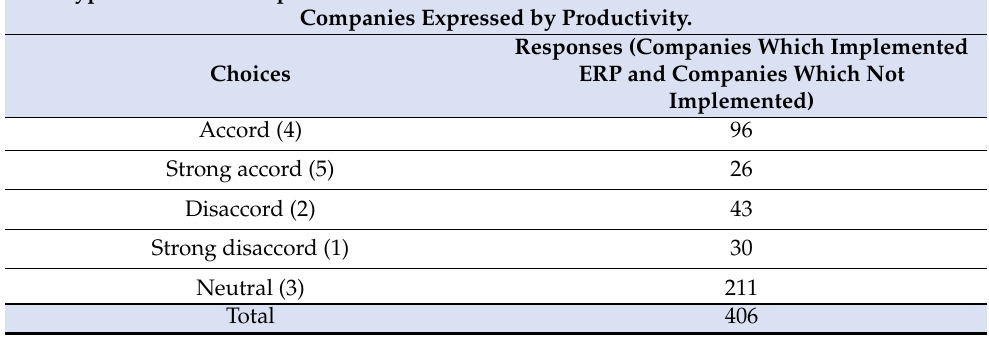
Table 5. Results of questionnaire responses for Hypothesis 2-total respondents.